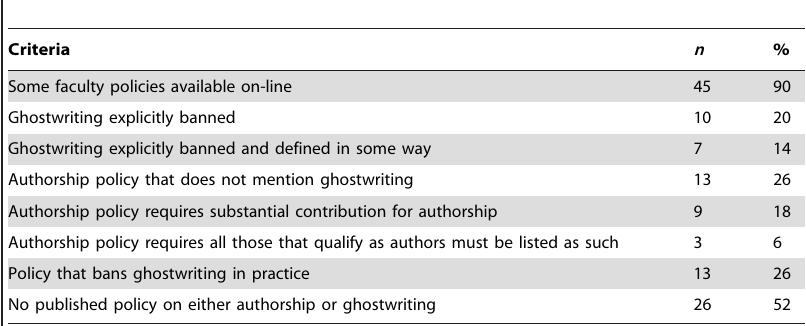
Table 1. Published policies of academic medical centers meeting specific criteria ( n